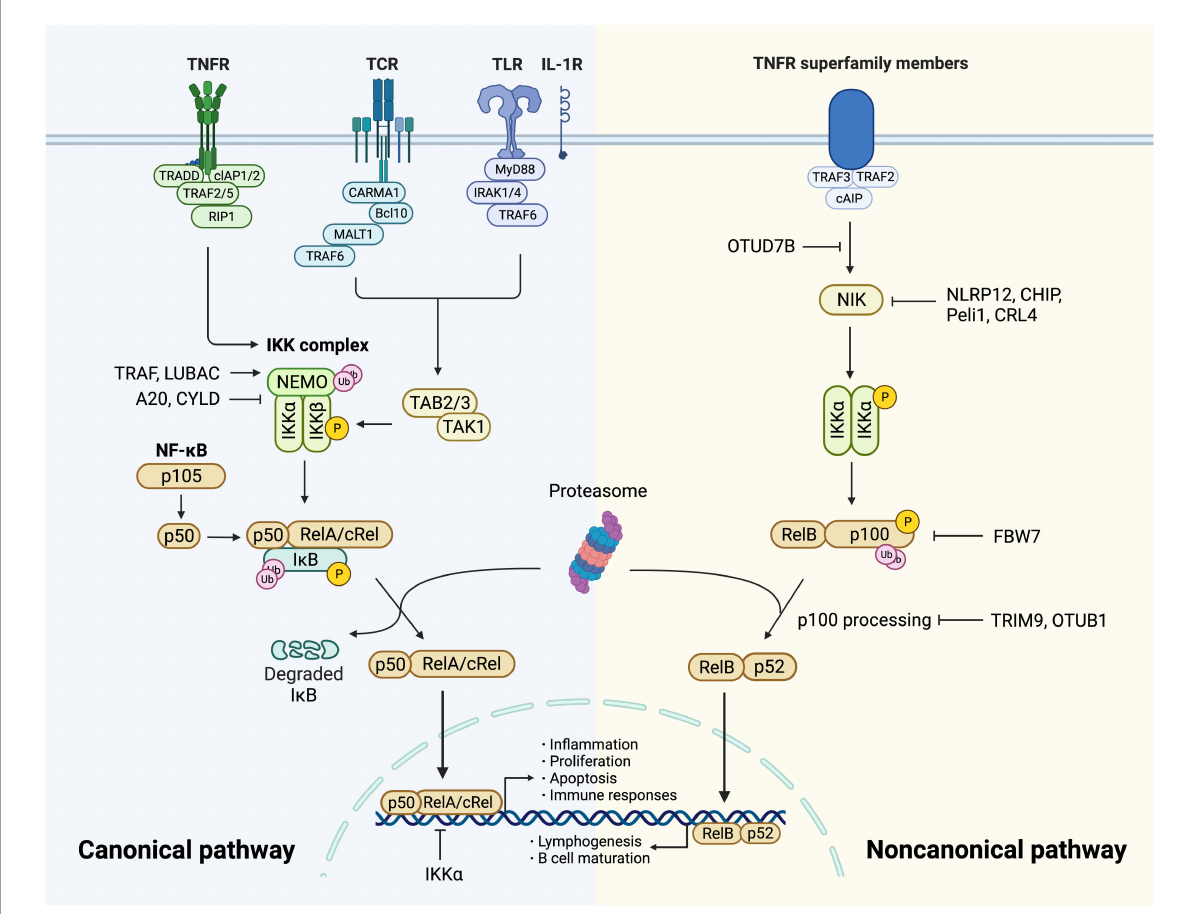
FIGURE1 Canonical and non-canonical NF- κ B pathway. The canonical pathway is induced via activation of receptors like TNFR, TCR, TLR, and IL-1R. When TNFR is activated by ligands, it recruits TRADD and drives the assembly of cIAP, TRAF, and RIP1 which is then recruited to NEMO and subsequent formation of IKK complex. TCR recruits CBM complex which is then ubiquitinated by TRAF6, resulting in the activation of TAK1. TLR and IL-1R recruits MyD88 and IRAK1/4, followed by TRAF6 to activate TAK and then IKK complex. TAK1 phosphorylates and activates IKK complex via phosphorylation of IKK β . Then I κ B family members phosphorylated by IKK undergo ubiquitin-dependent degradation, resulting in the release of NF- κ B dimers. The canonical NF- κ B pathway is regulated precisely. IKK α impedes RelA binding to DNA in nucleus. A20 and